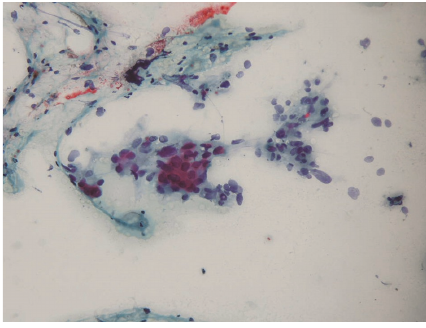
Figure 2: FNA biopsy demonstrates presence of atypical cells as clusters, suggestive for malignancy (Case 8).